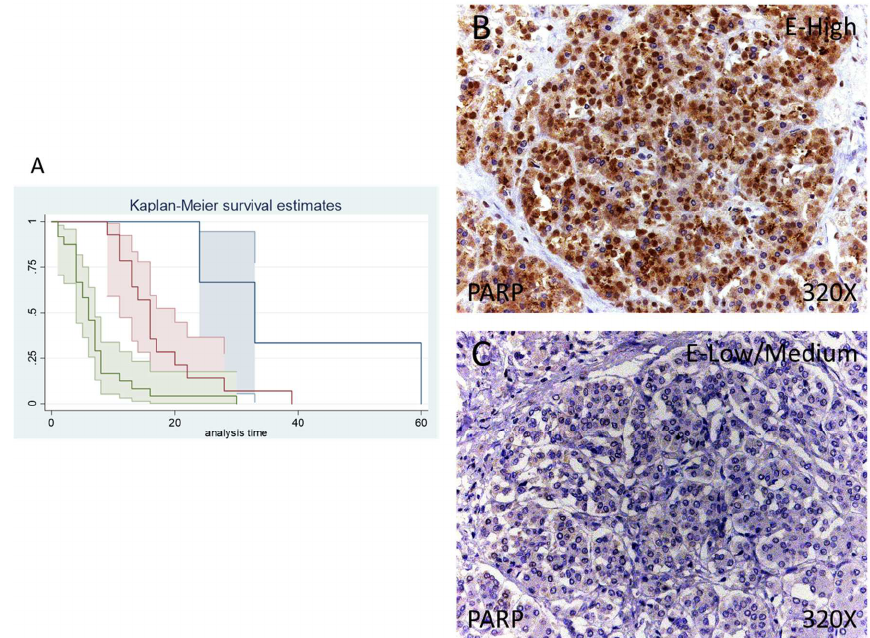
Figure 1. ( A ) Kaplan–Meier curves for survival time according to tumor expression of PARP. Blue curve = tissue expression classified as negative, red curve = tissue expression classified as low/medium, green curve = tissue expression classified as high. ( B , C ) Images showing the protein expression of PARP in patients diagnosed with pancreatic cancer. 3.3. Patients with Increased NOX1 and NOX2 Expression Display a Poorer Prognosis Of 41 patients, 39 were positive for NOX1 expression (95.12%) whereas 2 (4.88%) were negative for this component. Following our immunohistochemical results, 39.02% of patients exhibited low/moderate and 56.98% high NOX1 expression (Figure 2B,C). Median survival of patients with a negative expression of NOX1 was 17 (17–60) months, whereas low/moderate NOX1 was 16 (13–24) months and high NOX1 was 6 (4– 7) months. There was a hazard ratio of 2.765 of mortality in patients with a high NOX1 expression in comparison to those with a low/moderate expression. The global compari- sons defined how the significance value was p < 0.001.